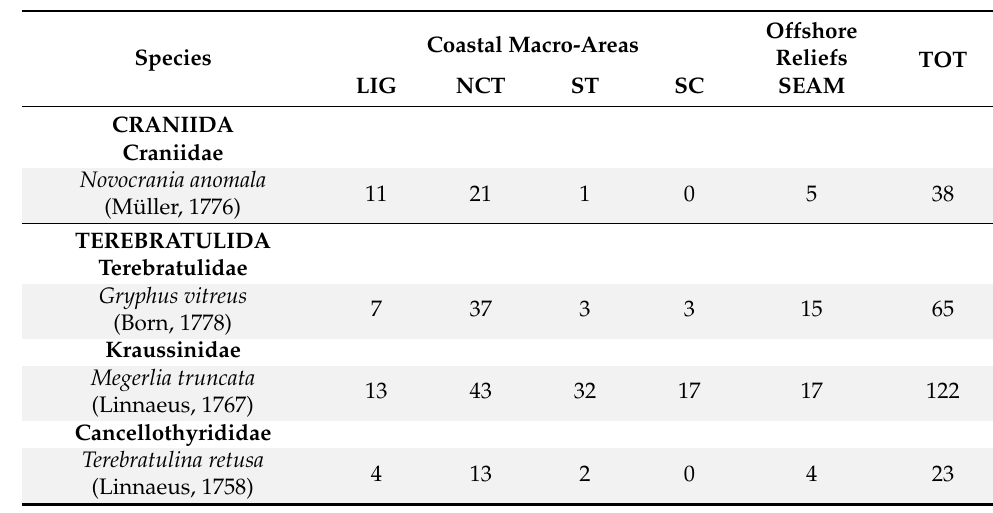
Table 1. List of the brachiopod species found in the present study. The number of sites in which each species was recorded per geographic area is given. LIG, Ligurian Sea; NCT, North-central Tyrrhenian Sea; ST, southern Tyrrhenian Sea; SC, Sicily Channel; SEAM,